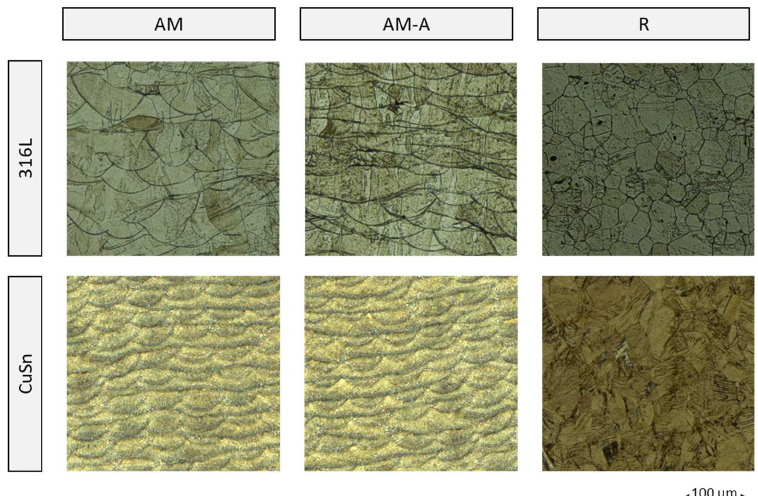
Figure 5. Comparison of investigated microstructures.